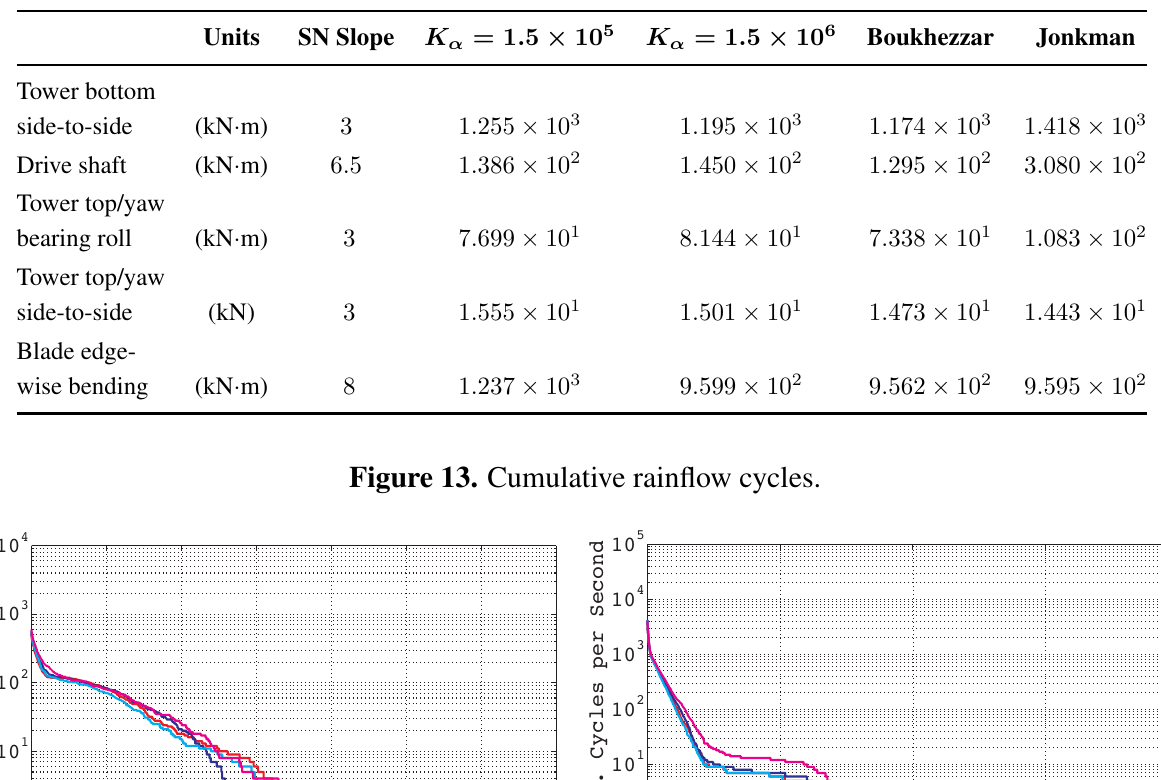
Table 2. Table of damage-equivalent loads.